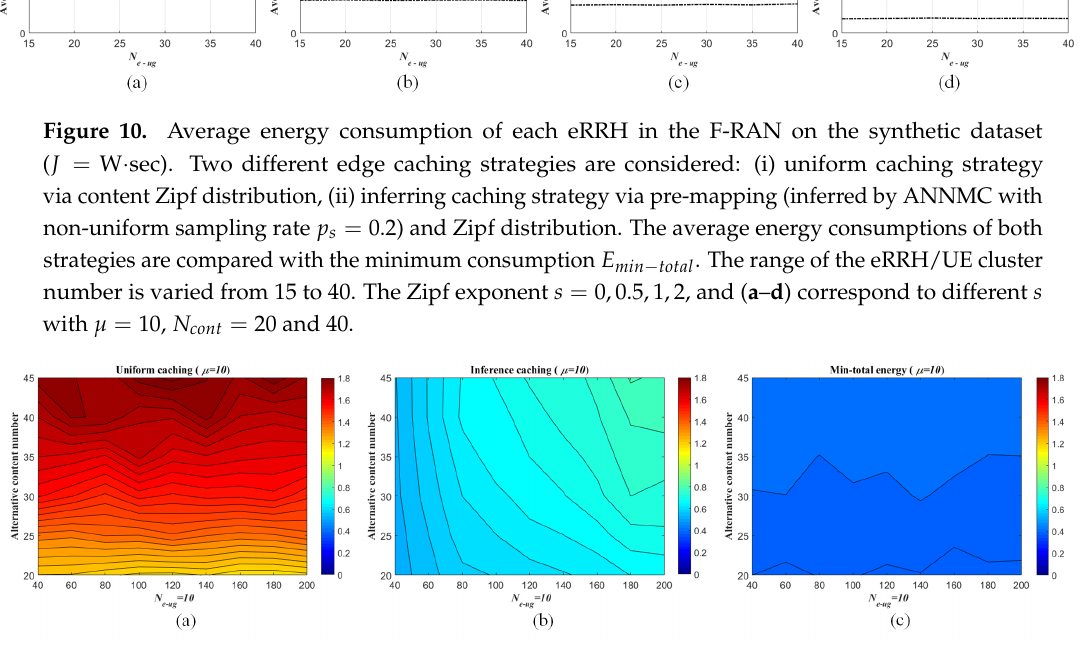
Figure 11. Average energy consumption range of each eRRH in the F-RAN on the synthetic dataset (measured as J ) with the setting that µ = 10 and Zipf exponent s = 0.5. ( a ) is the uniform caching strategy via content Zipf distribution; ( b ) is the proposed inferring caching strategy via pre-mapping (inferring by ANNMC with non-uniform sampling rate p s = 0.2) and Zipf distribution; ( c ) is the minimum consumption E min − total